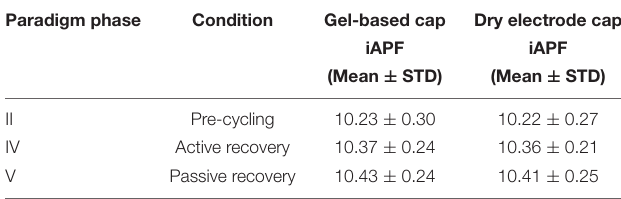
TABLE 1 | Mean and standard deviation (STD) of the iAPF values (in Hz) for Phases II, IV, and V of the study paradigm. Paradigm